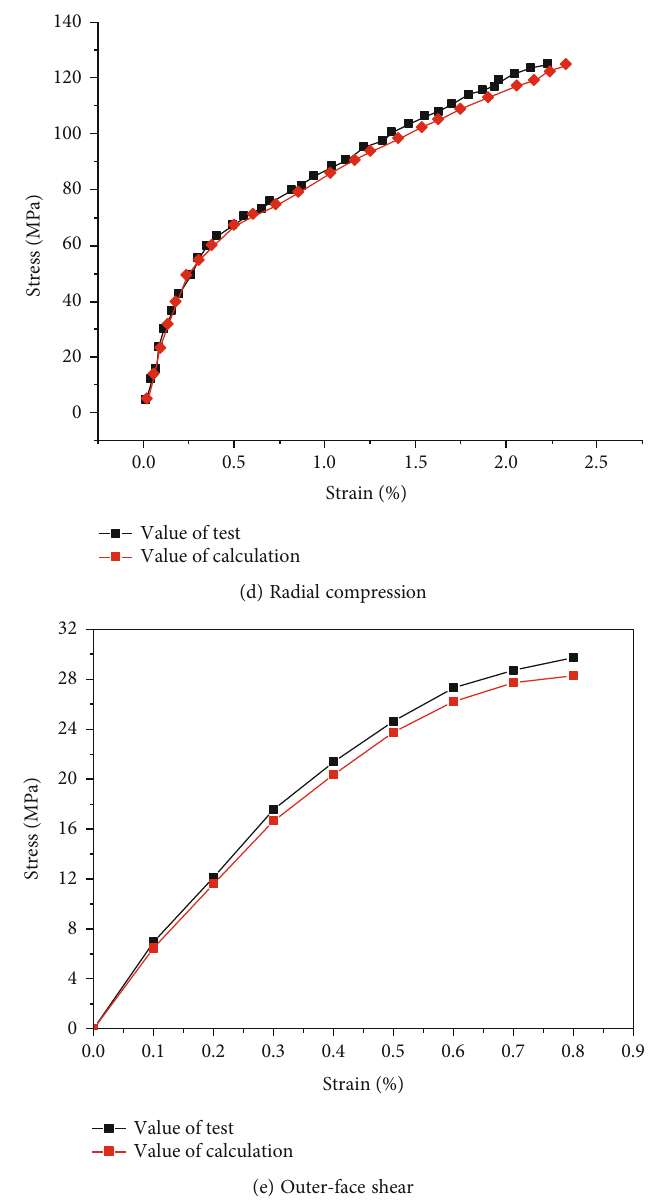
Figure 4: The predicted curves of the constitutive model compared with the test curves.